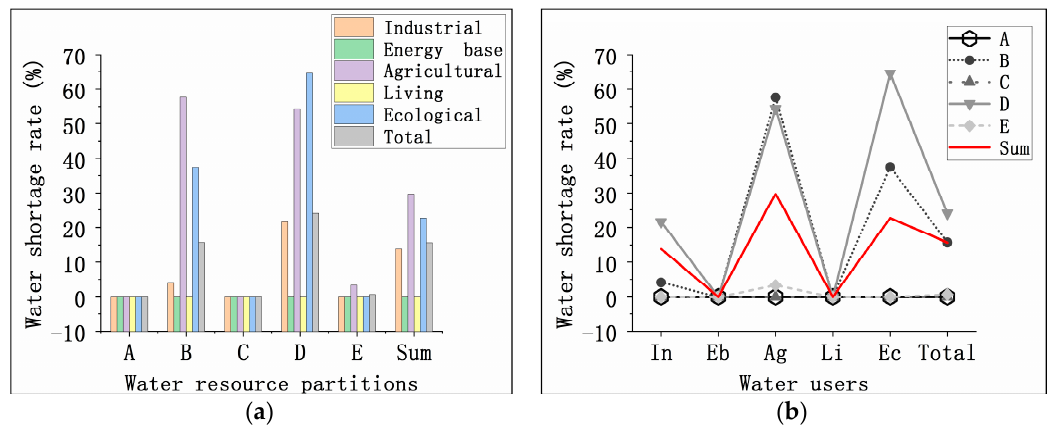
Figure 4. ( a ) Different water resource partitions, ( b ) different water users’ water shortage rate analysis chart of weights distribution method (In the figure, Pastoral Energy Industry Partition, Farming-Pastoral